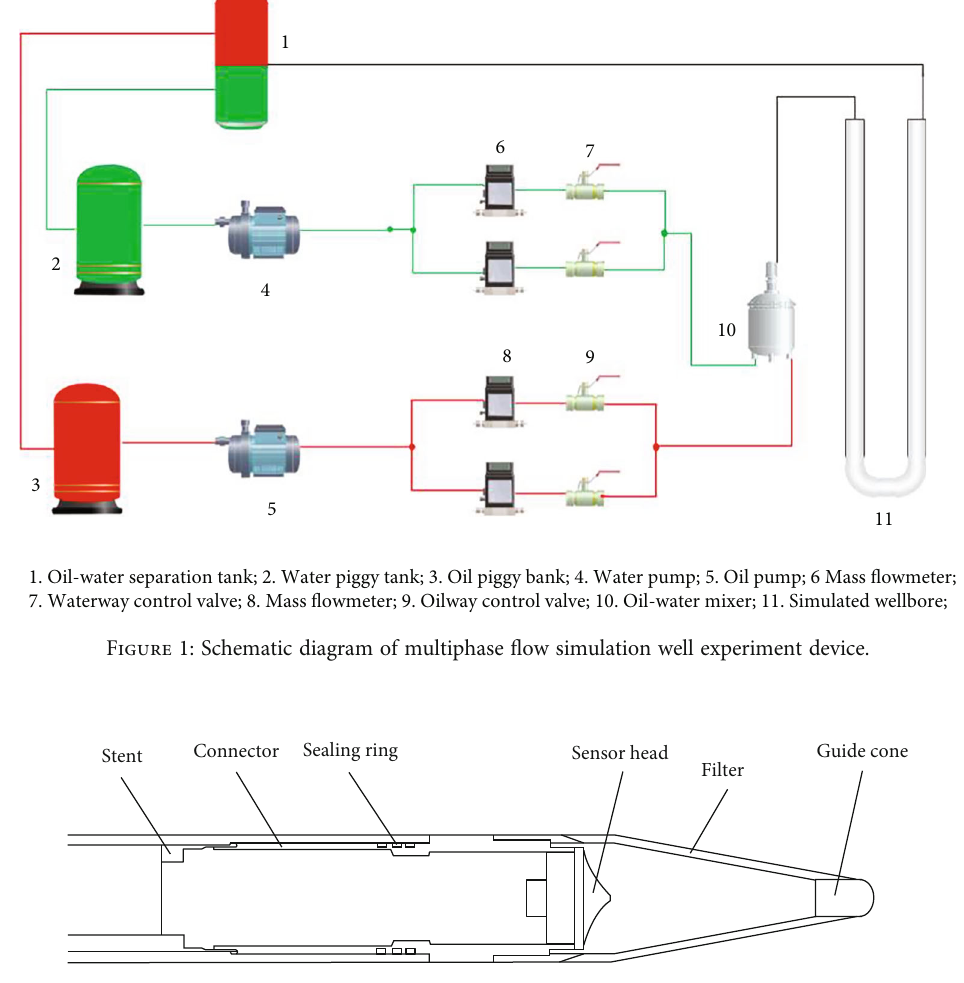
Figure 2: Schematic diagram of ultrasonic multiphase fl ow logging tool structure.